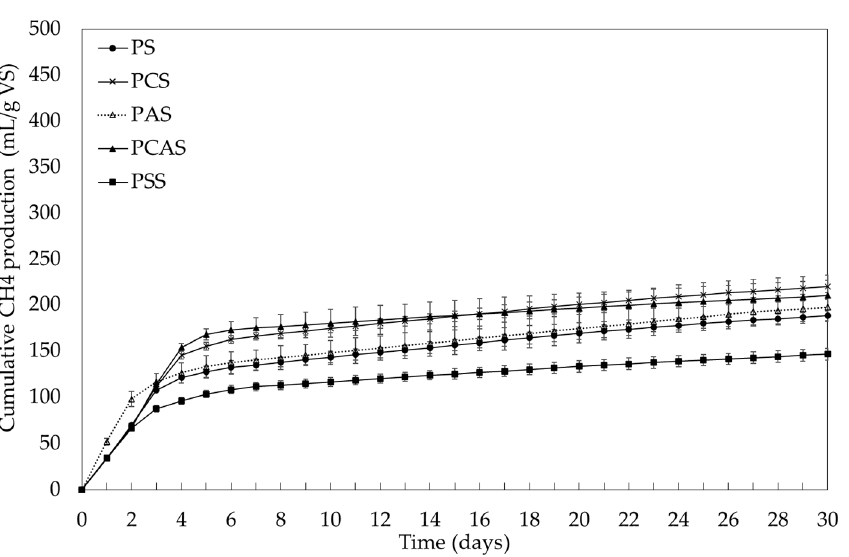
Figure 4. Cumulative methane production (mL/g VS) for SIR = 1:2 g VS substrate/g VS IN (error bars indicate standard deviation of mean values). Table 2. Performance of the different substrates at the two different substrates to inoculum ratios (SIR). SIR